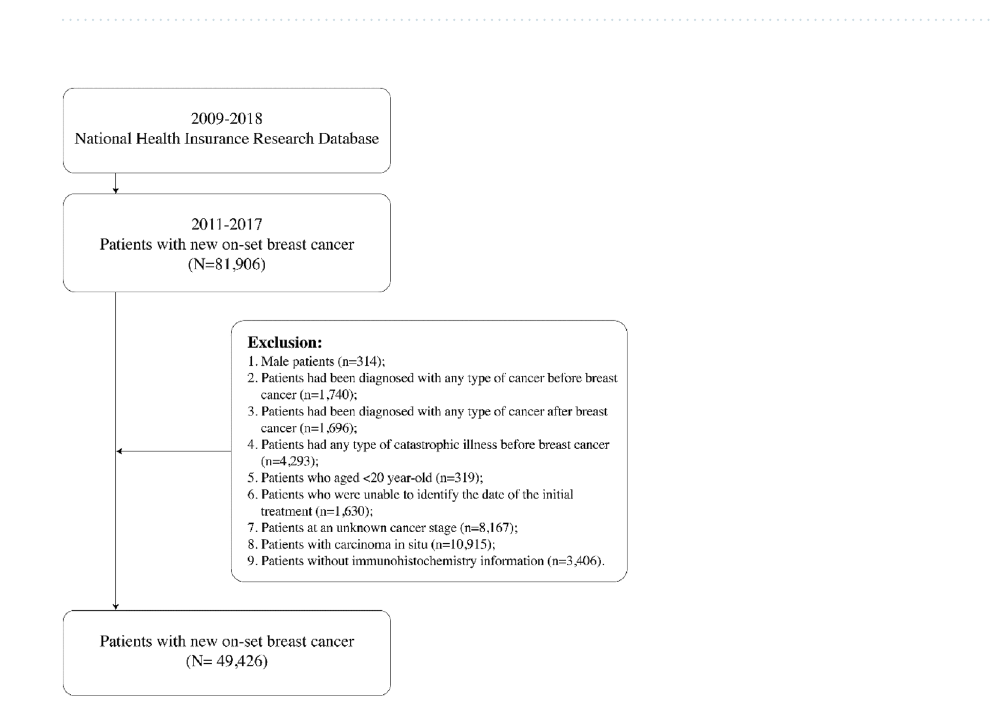
Figure 3. Study participant selection